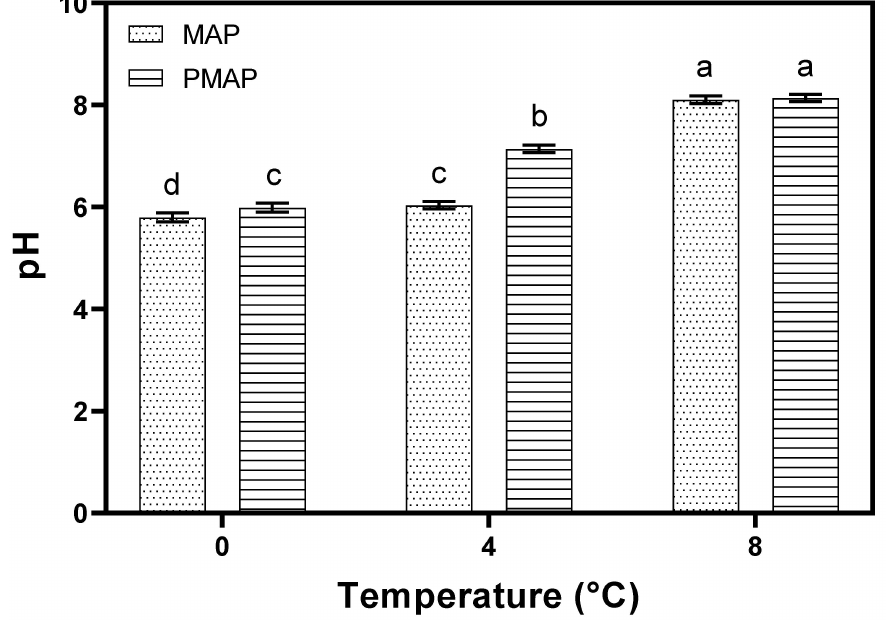
Figure 3. Effects of active and passive modified atmosphere packaging and storage temperatures (0 ◦ C, 4 ◦ C, and 8 ◦ C) on the change in pH on day 3. Different letters represent mean values that are significantly different ( p < 0.0001). MAP = active-MA and PMAP =